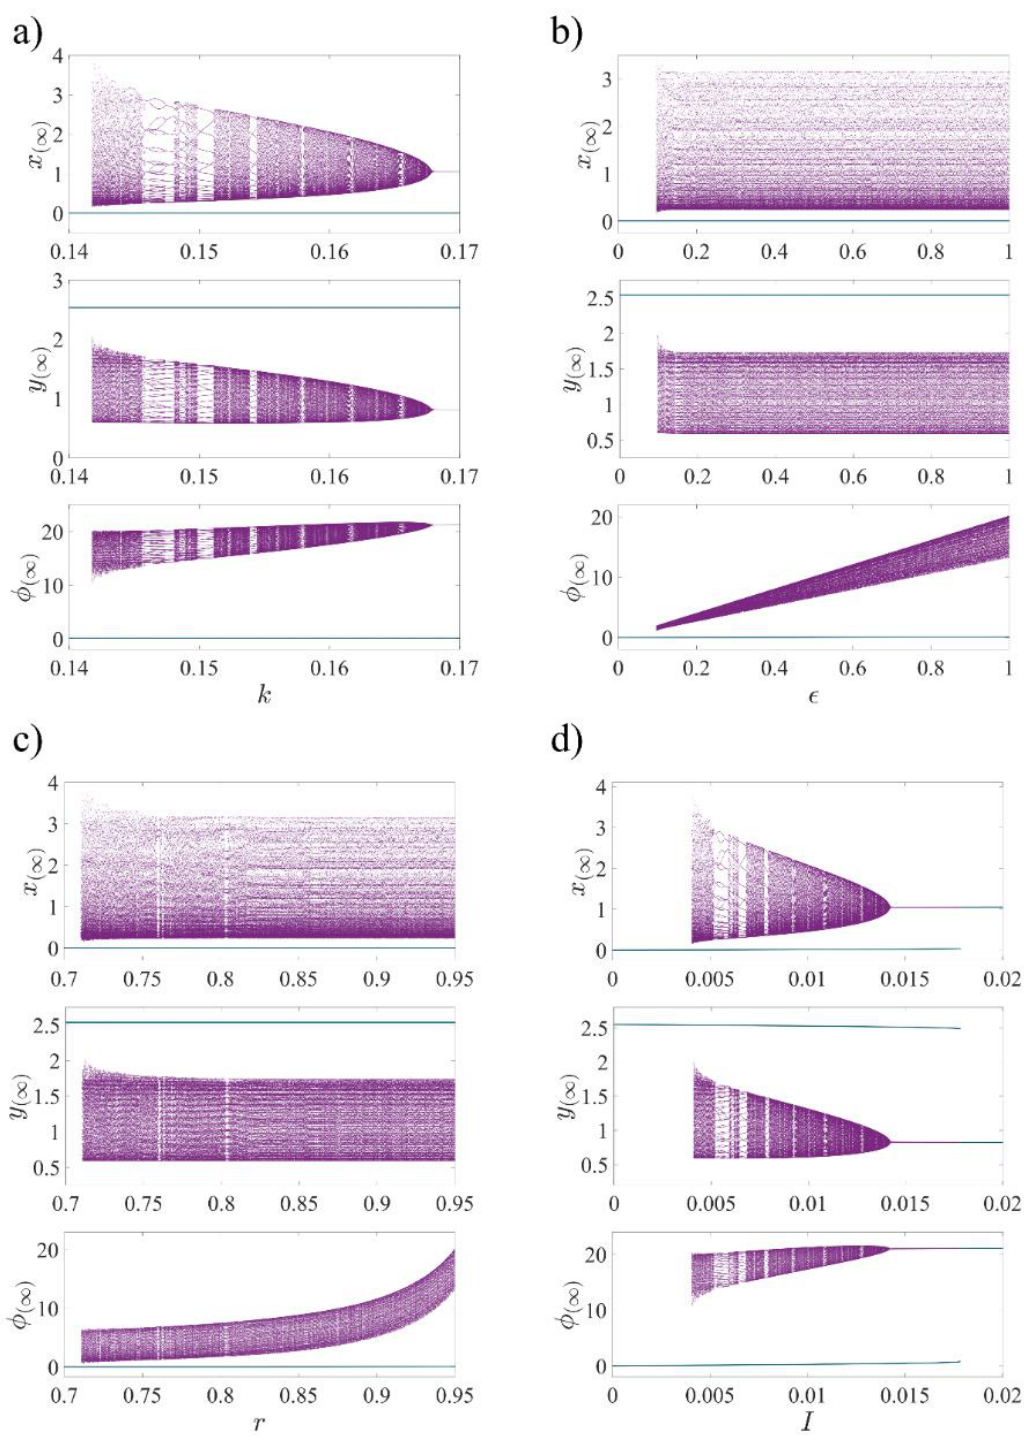
Figure 1. The bifurcation diagram of 3D-MCM versus system parameters: ( a ) the magnetic strength, 𝑘 ; ( b ) the scale factor of time, 𝜖 ; ( c ) the scale factor of flux, 𝑟 ; and ( d ) the injected ion current, 𝐼 . Excluding each bifurcation parameter in the panels, the other parameters are set, as mentioned in Table 1. The diagram in purple is plotted with the initial conditions (𝑥(0), 𝑦(0), 𝜙(0)) = (1.0, 0.8, 0.2) , and the one in blue is plotted with the initial conditions (𝑥(0), 𝑦(0), 𝜙(0)) = ( 0.5 , 0.2 , 0.3) , indicating that the 3D-MCM has coexistence of an oscillating attractor and a fixed- point attractor.